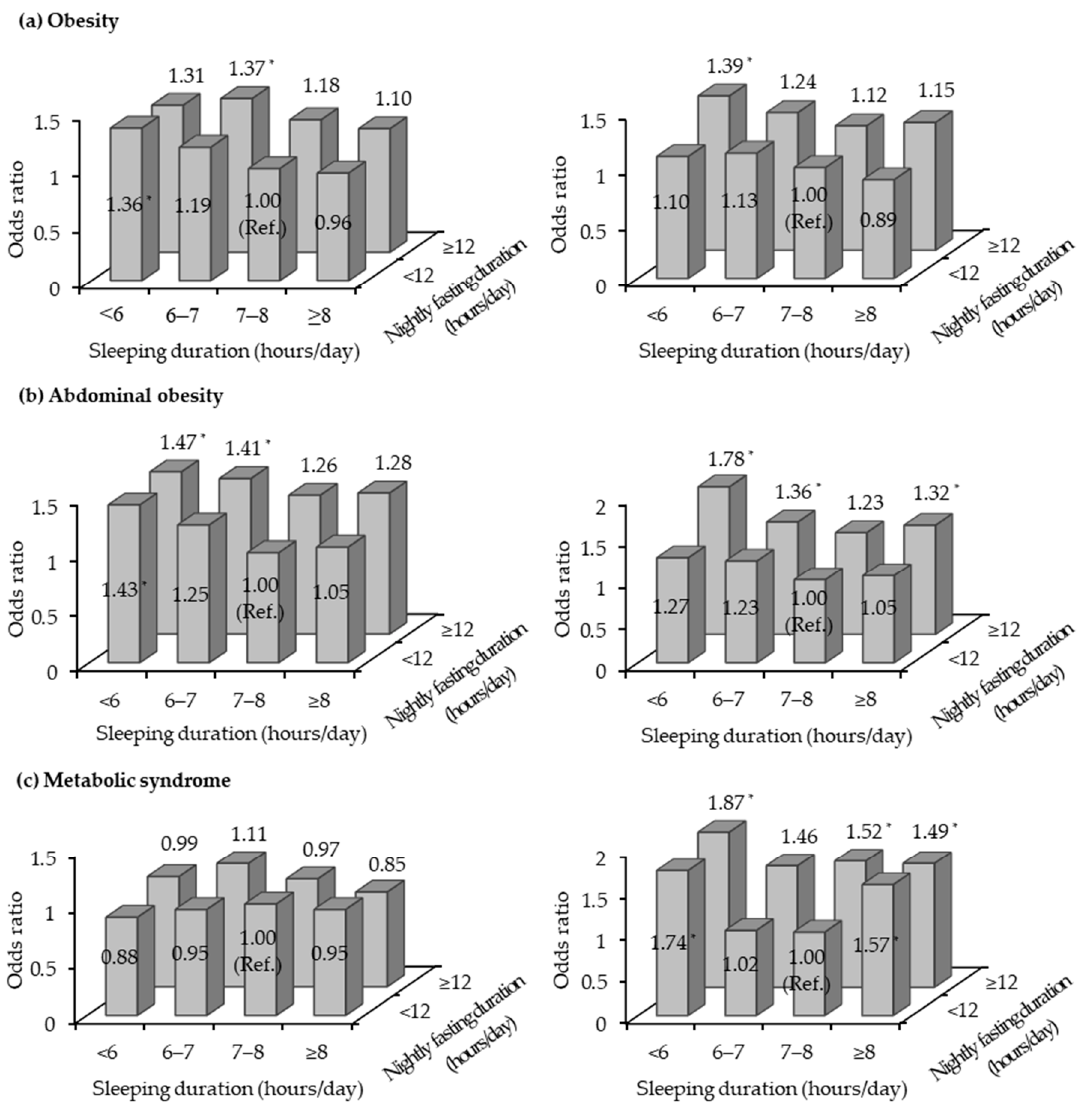
Figure 1. Multivariable-adjusted odds ratios for obesity ( a ), abdominal obesity ( b ), and metabolic syndrome ( c ) according to nightly fasting duration and sleep duration in men (left side) and women (right side). Adjusted for age, body mass index (except for obesity and abdominal obesity), education, household income, type of work, survey period, alcohol consumption, smoking, physical activity, and total energy intake. * indicates statistical significance.